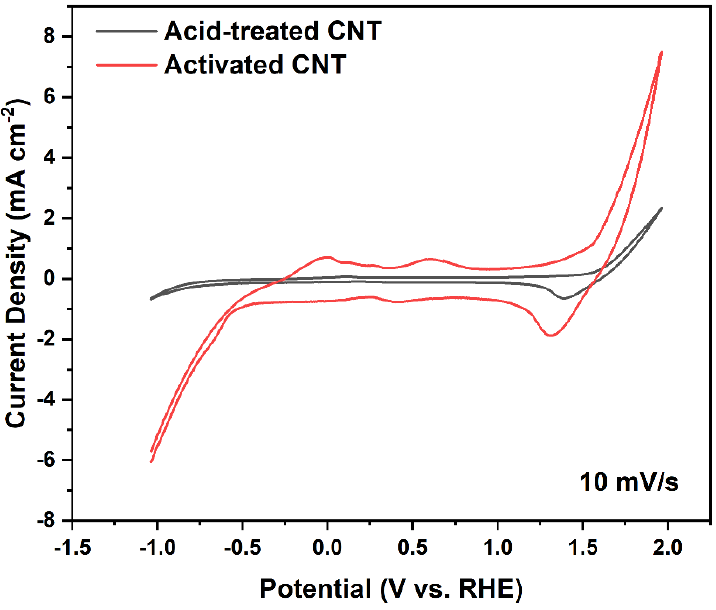
Figure 2. CV curve of acid-treated and activated CNT.